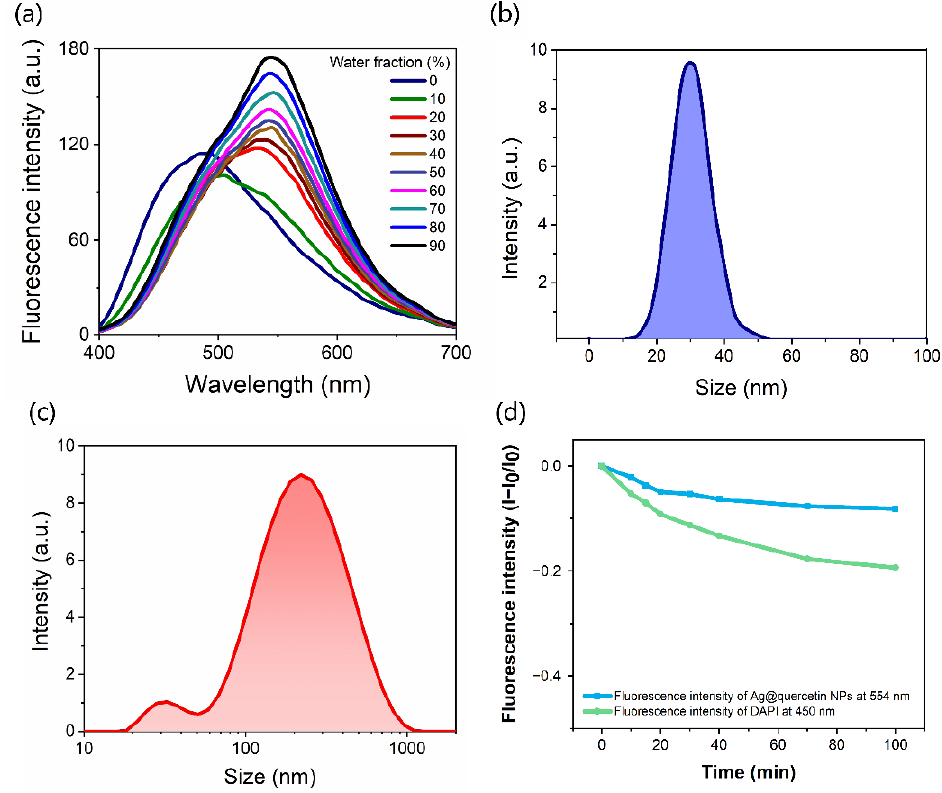
Figure 3. Fluorescence and particle size of Ag@QCNPs. ( a ) Fluorescence spectra of Ag@QCNPs (10 μg/mL) in mixtures of THF and water (excitation wavelength = 370 nm); ( b ) DLS profile of Ag@QCNPs in THF; ( c ) DLS profile of Ag@QCNPs in THF/water (9:1 v:v ); ( d ) Changes in intensity of maximum fluorescence emission of Ag@QCNPs (554 nm) and DAPI (450 nm) during irradiation with ultraviolet light.